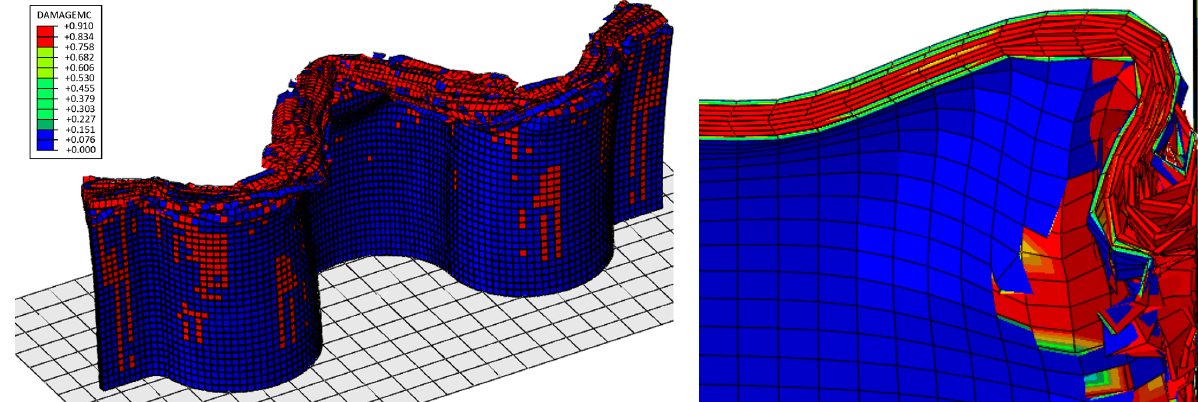
Figure 13. Simulated deformed shapes of the sinusoidal specimen with 3 curvatures: isometric view with demonstrated matrix failure ( left ) and cross-sectional view from the mid-plane ( right ).